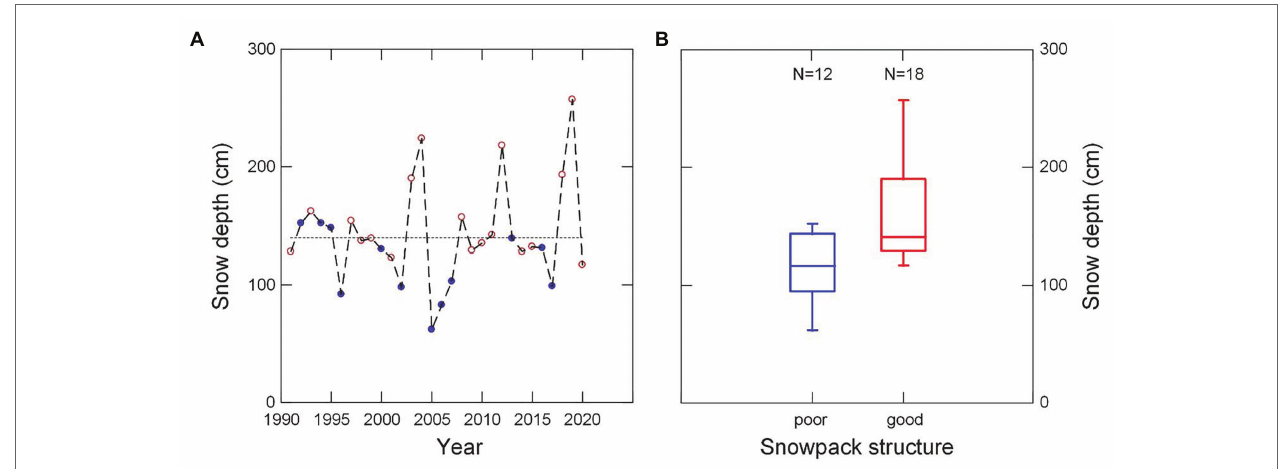
FIGURE 2 | Snowpack structure in relation to snow depth for the Weissfluhjoch study site 2,540 m (Davos, Switzerland) for the 30-year period 1990–1991 to 2019–2020. (A) Snow depth in mid-January with full blue circles indicating poor snowpack structure, and red open circles indicating good snowpack structure. Snowpack structure is classified based on snow profile type as described by Schweizer and Wiesinger (2001): “poor” corresponds to profiles types 1–5, (with weak basal layers), “good” to profile types 6–10, (with well-consolidated basal layers). (B) Snow depth by snowpack structure class. With poor snowpack structure snow depth is significantly lower than with good structure (median: 117 vs. 141 cm; Mann-Whitney U-Test, p = 0.012). Boxes span the interquartile range from 1st to 3rd quartile with a horizontal line showing the median. Whiskers show the range of observed values that fall within 1.5 times the interquartile range above the 3rd and below the 1st